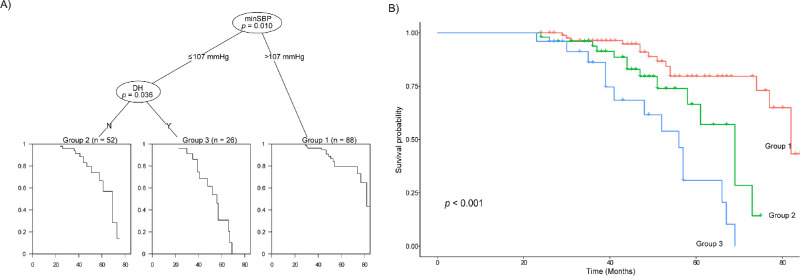
(A) Decision tree analysis for progressive peripapillary retinal nerve fiber layer thinning; (B) Kaplan-Meier analysis showing significant differences in the progression rate between the three groups defined by the tree analysis. MinSBP, minimum systolic blood pressure; DH, disc hemorrhage.